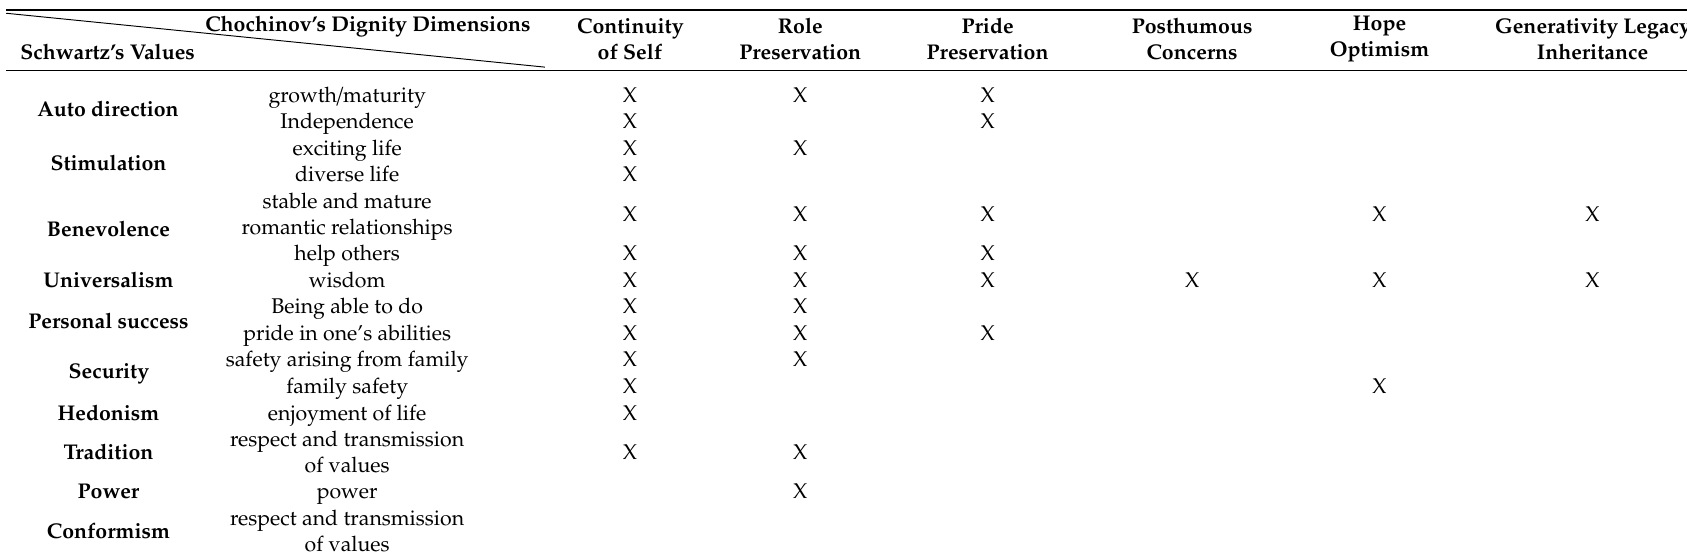
Table 3. Intersections between Quasi-Circumplex Model of Human Values (QCMHV) and Model of Dignity in the Terminally ill Patient (MDTP). Schwartz’s